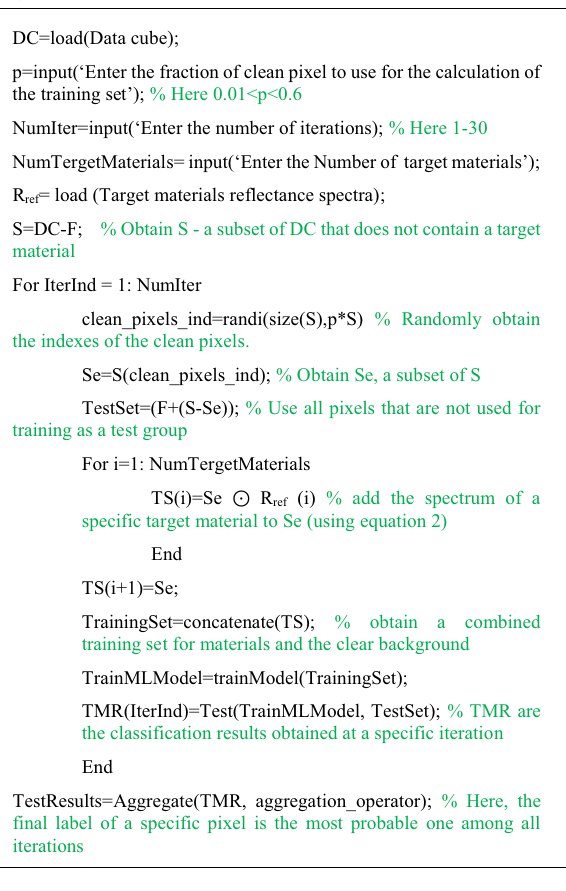
Algorithm 1 – Machine Educa(cid:31)on